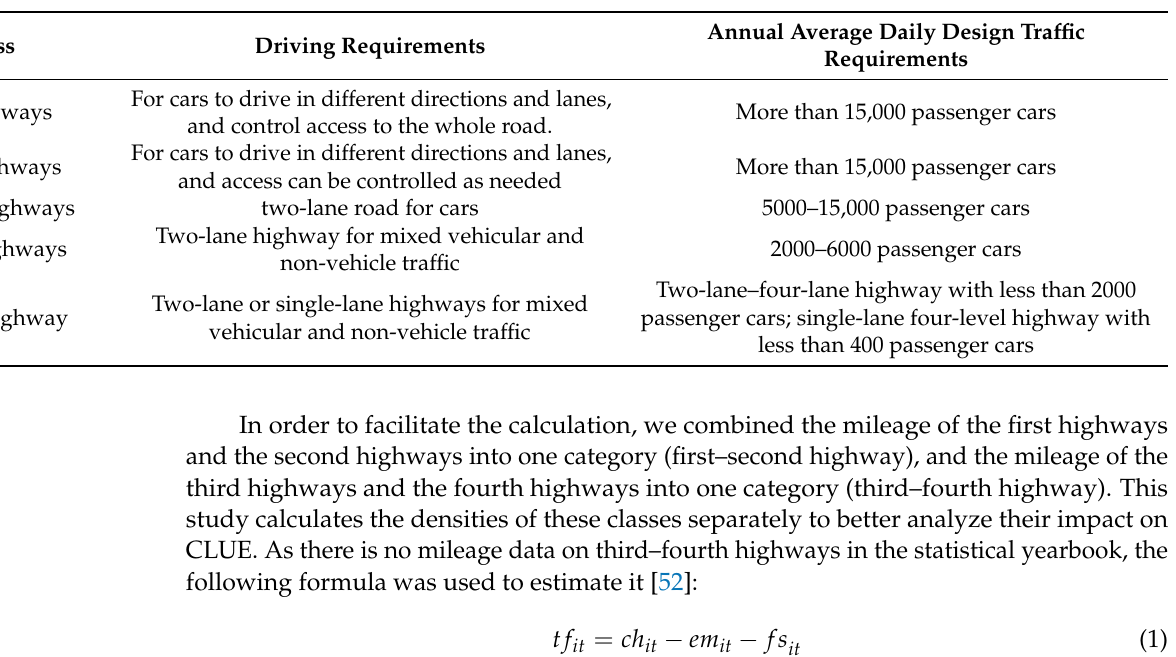
Table 2. Classification of highways in